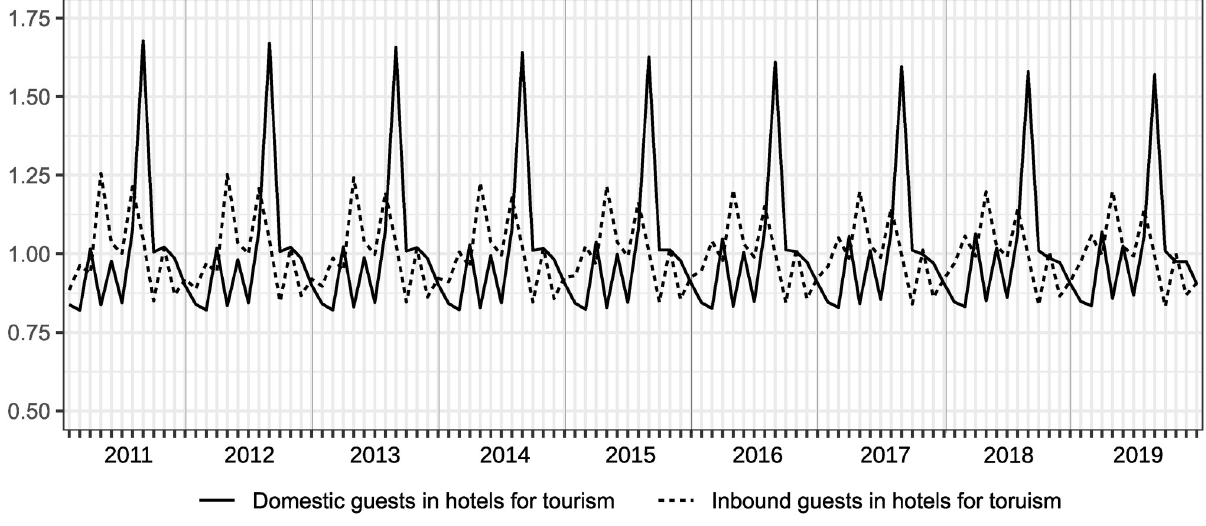
Fig 3. Seasonal factors of overnight guests in hotels for tourism over 2011 to 2019.